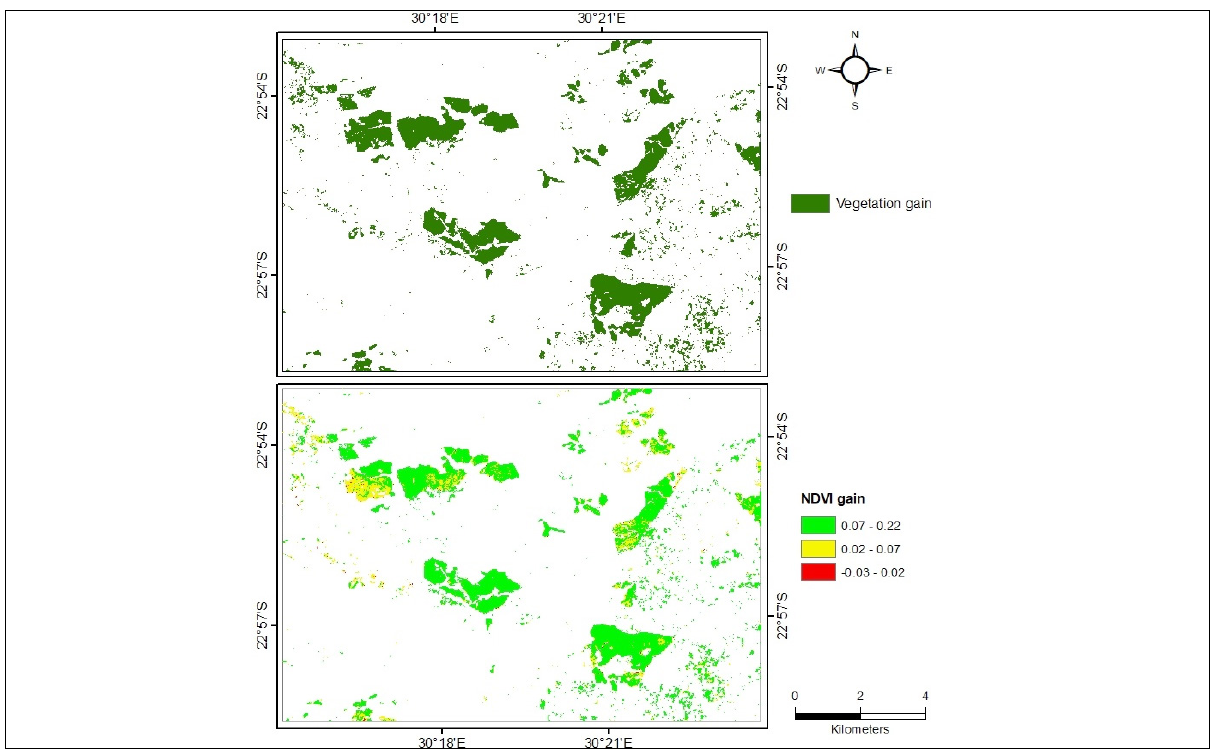
Figure 9: Vegetation gain vs Normalised Difference Vegetation Index (NDVI) gain.